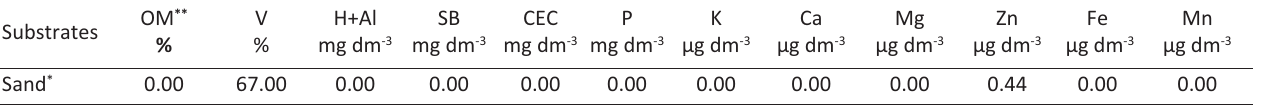
Table 1 ­ Average chemical composition of the sand substrates used in the production of peach tree rootstocks (CEC).Substrates *sand; **OM= Organic Matter; V= Base saturation; SB= Sum of Bases; CEC= Cation Exchange Capacity